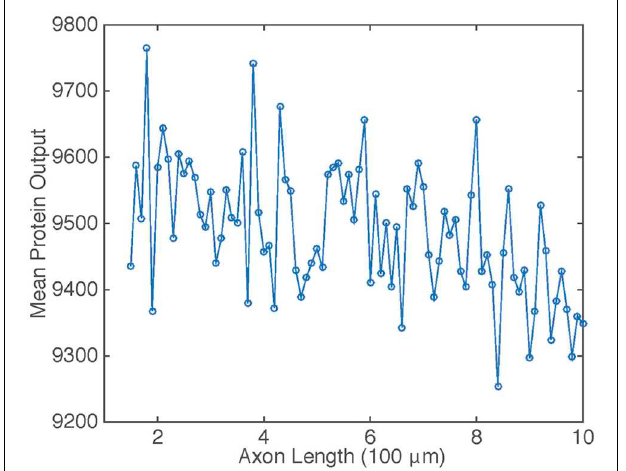
FIGURE 7 | Schematic diagram illustrating how the presence of noise in the protein output leads to an uncertainty 1 L in the critical axonal length L 0 at which the threshold is crossed. An analogous result applies to decoding of protein concentration gradients. If we ignore the correction factor in Equation (16)